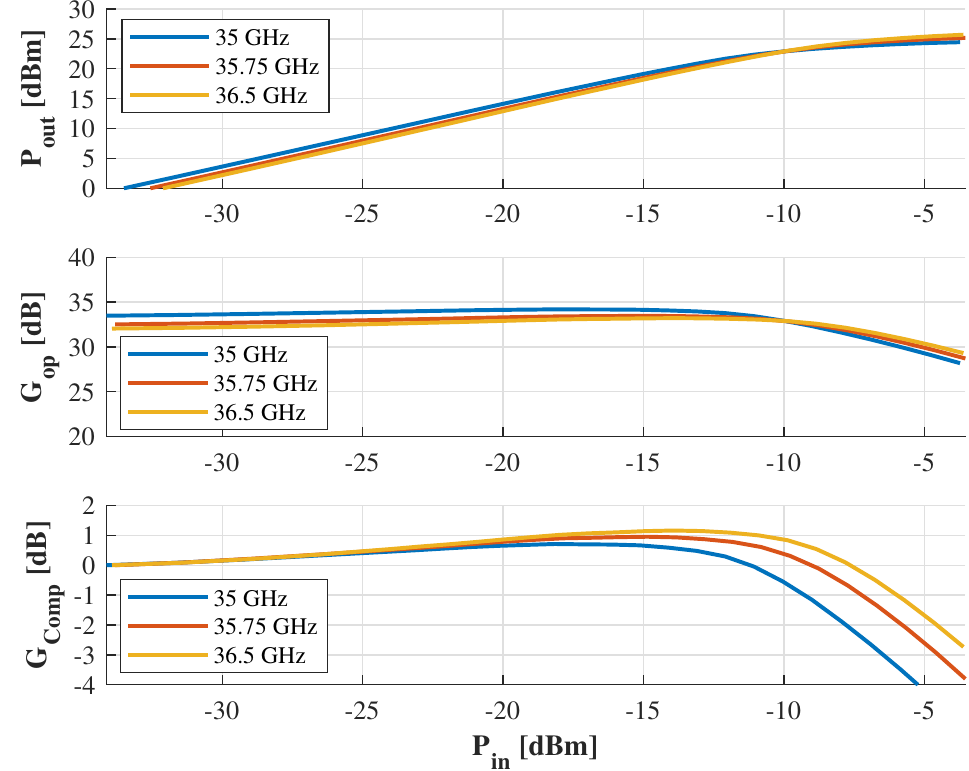
Figure 11. Measured output power, operative gain, and gain compression of a tested LNA cell at the bottom, middle, and top operative